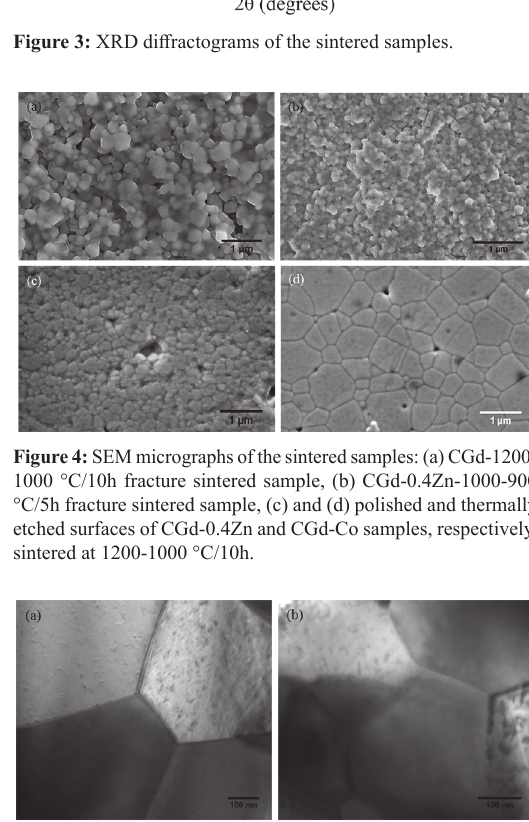
Figure 5: Dark field TEM micrographs of (a) CGd and (b) CGd- 1Zn samples sintered at 1200-1000 °C/10h. integrity of cells 6 . The addition of either Zn or Co caused a small change in the Ce 3d spectra, indicating only a partial reduction of cerium, however, the impact of these additions on the n-type conductivity of CGd is